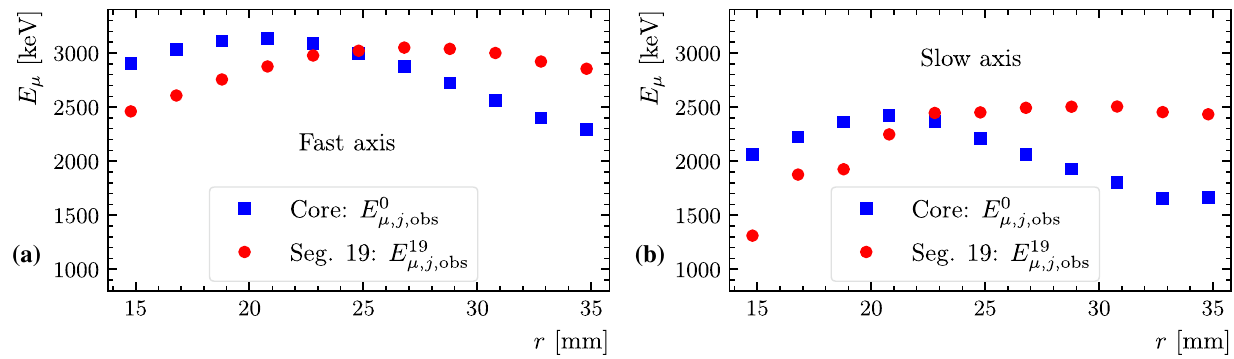
Fig. 14 The fitted E 0 μ, and E 19 μ, of the measurements from a RSF and b RSS. Error bars indicating uncertainties would be hidden by the j , obs j , obs markers